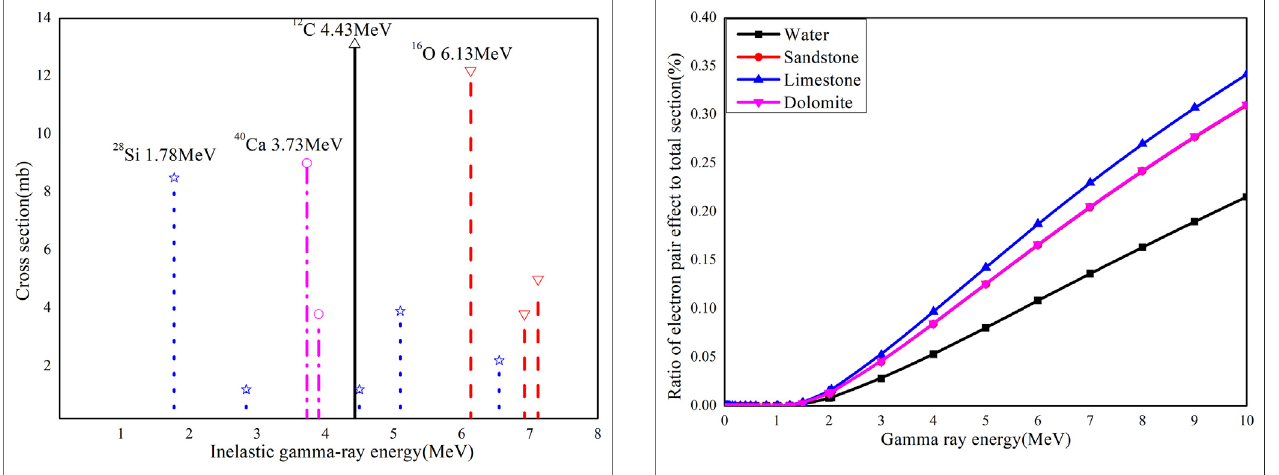
FIGURE8| Ratioofpairproductioneffecttototalmassattenuation.[The data are calculated with XCOM (Berger et al.,